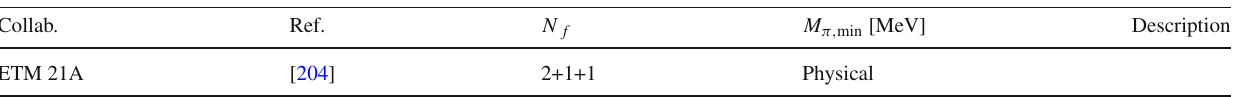
Table 81 Chiral extrapolation/minimum pion mass in determinations of m ud , m s and, in some cases, m u and m d , with N f = 2 + 1 + 1 quark flavours Collab. Ref.